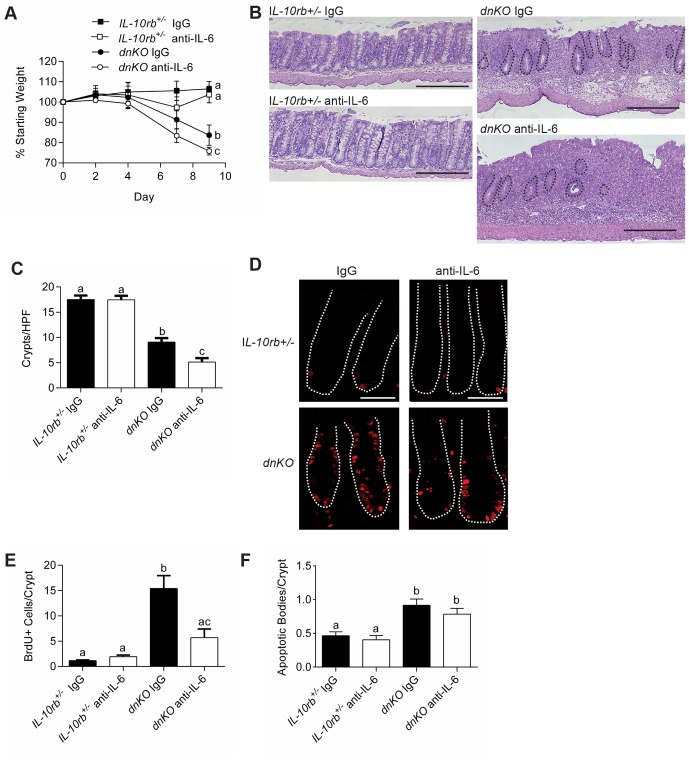
Inhibition of IL-6 resulted in more severe colitis and inhibition of intestinal epithelial proliferation.Colitis was induced in dnKO and IL-10rb+/- littermate controls by co-housing. On day zero and three times weekly, mice were injected intraperitoneally with 500 µg of either anti-IL-6 mAb or control IgG mAb. Two independent experiments were performed with 8-9 mice/group. (A) Plot of the average percent of starting weight ± SEM shown for indicated groups of mice. Mice were weighed every three days. (B) Representative H+E stained sections of descending colons at day 9 post co-housing. Bars = 500 µm. Black dotted lines outline remaining crypts in the dnKO anti-IL-6 mAb treated mouse histology. (C) Graph of the average number of descending colonic crypts per high-powered field ± SEM. (D) At day 9 post-co-housing, mice were injected with BrdU one hour before sacrifice. Representative colonic sections stained with mAb to BrdU and detected with fluorescently conjugated antibodies were shown. The white dotted lines delineate crypts. Bars = 100 µm. (E) Graph of the average number ± SEM of BrdU positive cells per crypt. (F) Graph of the average ± SEM number of apoptotic bodies/crypt. One-way analysis of variance: (A) F = 3.5, P<0.05 (for day 9 weights); (C) F = 57.36, P<0.0001; (E) F = 17.92, P<0.0001; (F) F = 10.87, P<0.0001. Means with different letters are significantly different by Bonferroni's multiple comparison test.